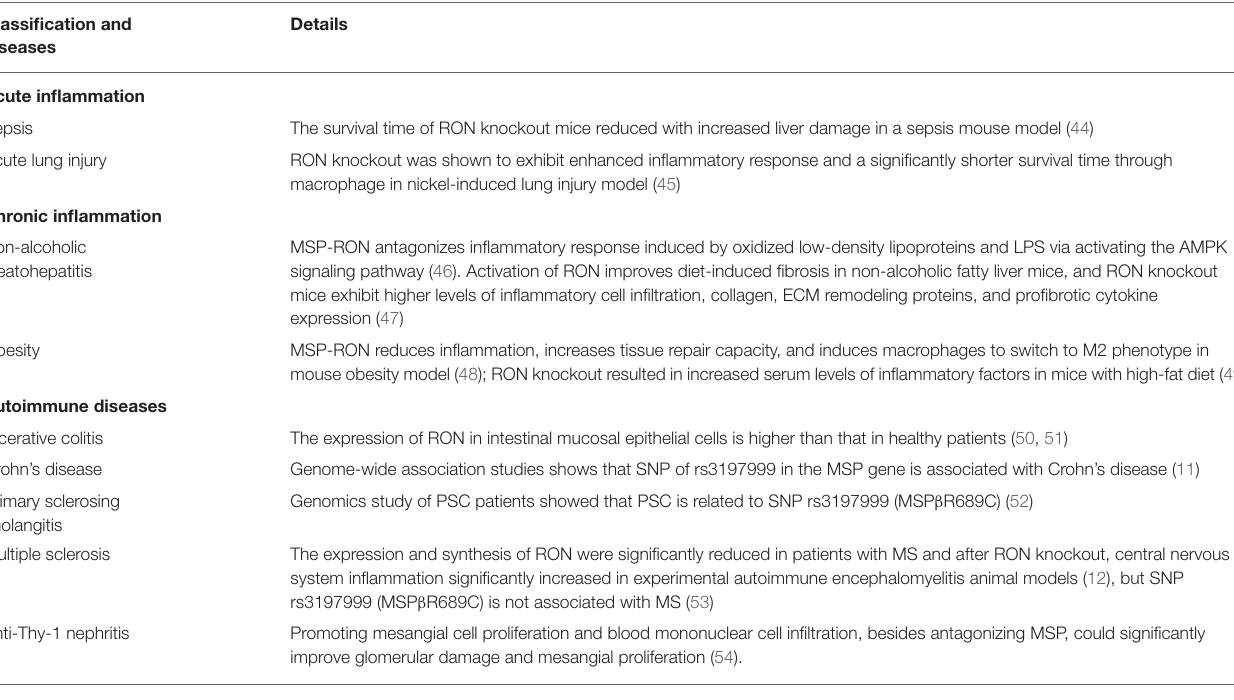
TABLE 1 | MSP-RON with clinical diseases. Classification and diseases